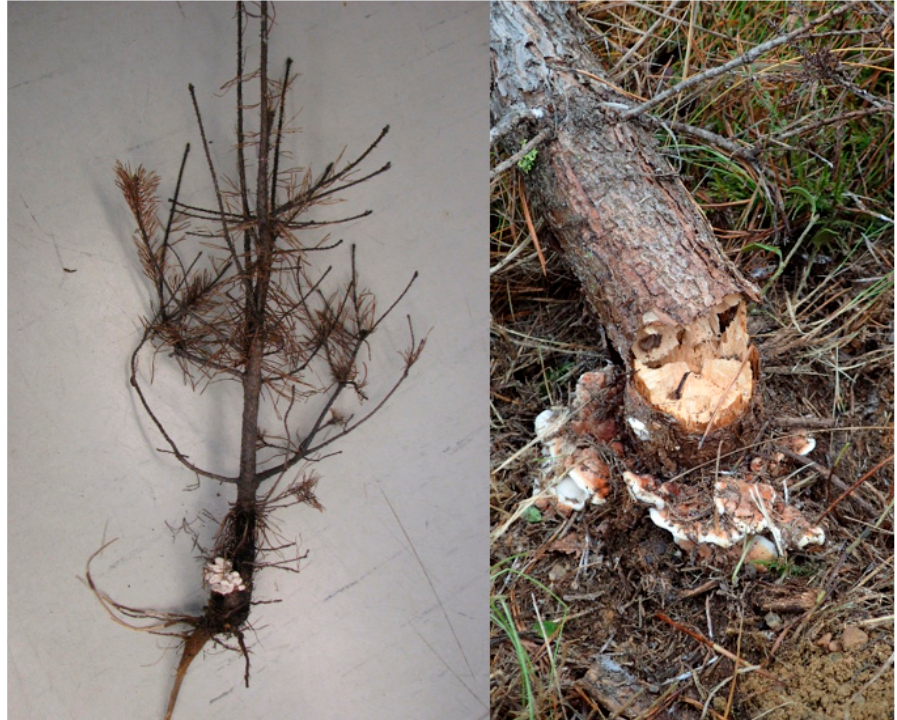
Figure 1. Fruiting bodies of Heterobasidion annosum s.s. on the base of a 5-year-old (on the left) and a 12-year-old pine (on the right).